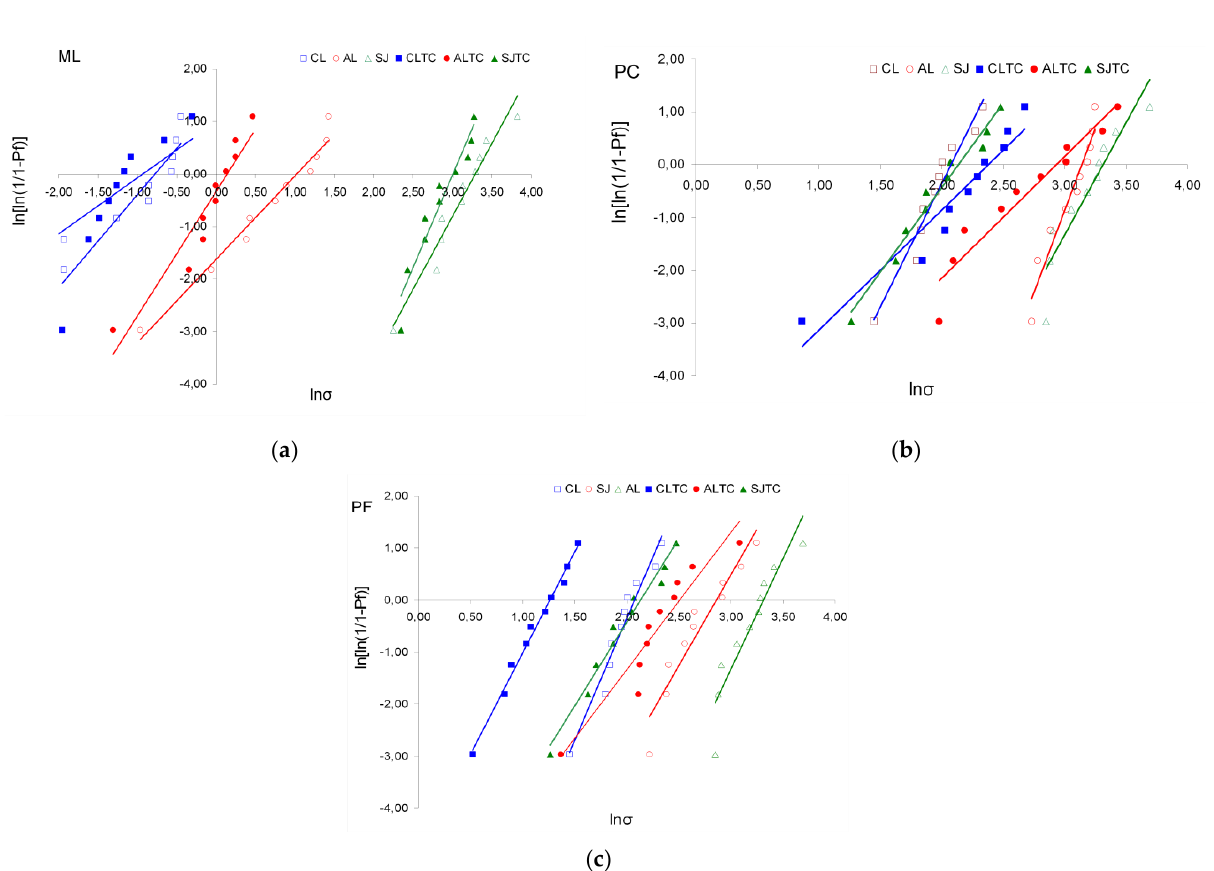
Figure 3. Means and standard deviations of the results of SBS.